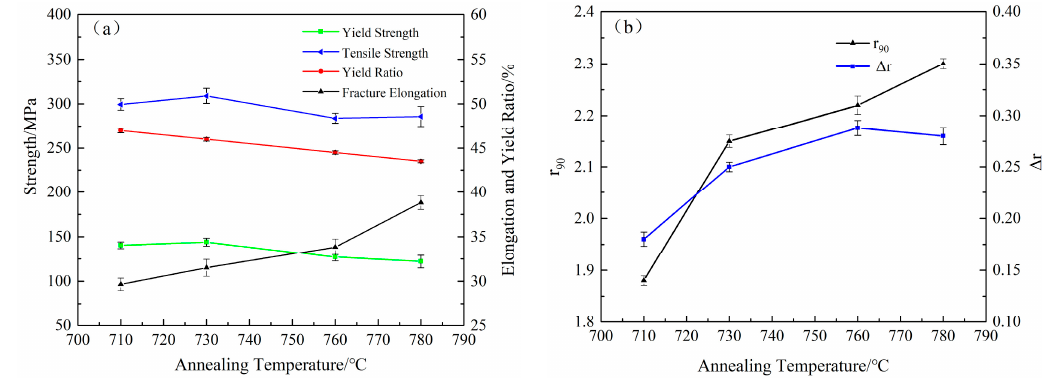
Figure 4. Effects of annealing temperature on mechanical properties. ( a ) Strength, elongation and yield ratio perpendicular to the rolling direction and ( b ) r 90 and Δ r .